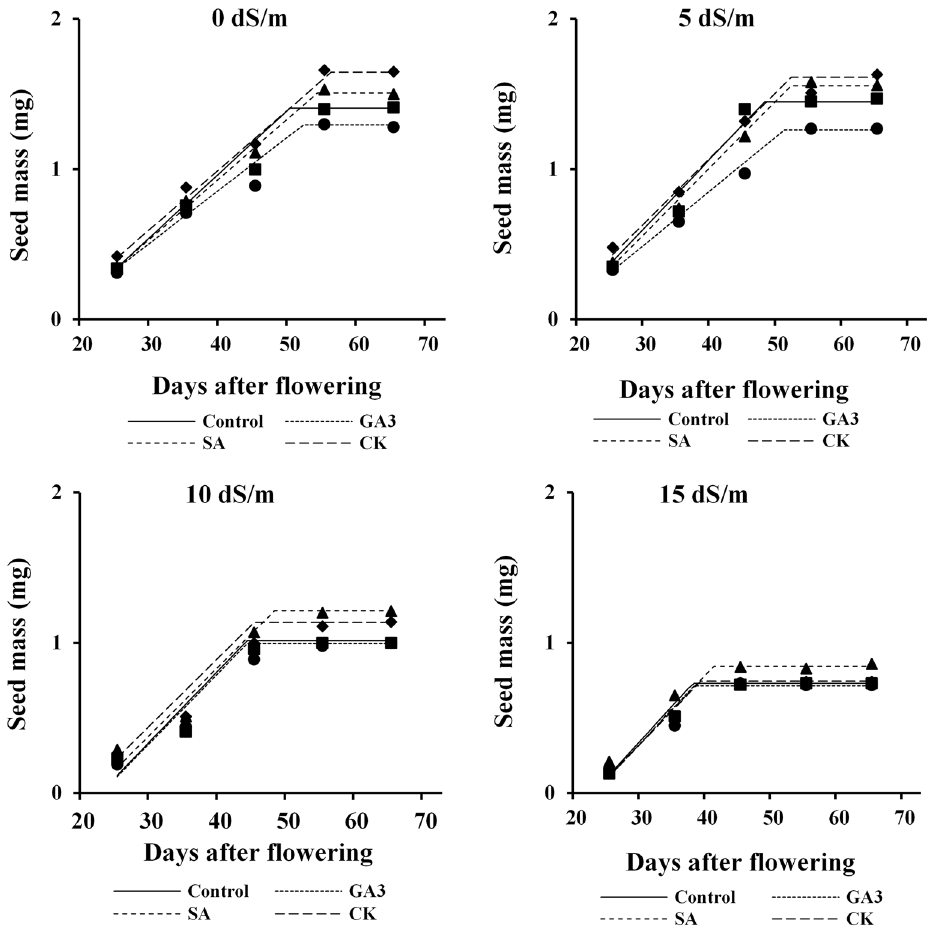
Figure 2. Changes in mean seed mass in response to salinity and hormonal treatments. GA 3 , SA, CK gibberellic acid, salicylic acid and cytokinin,